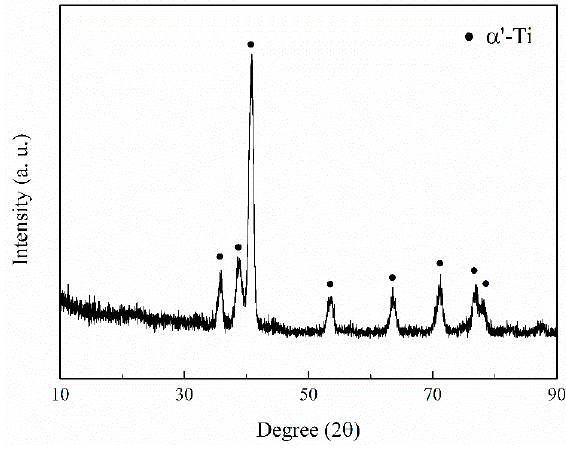
Figure 6. X-ray di ff raction pattern of W2 Figure 6. X-ray diffraction pattern of W2 weld.